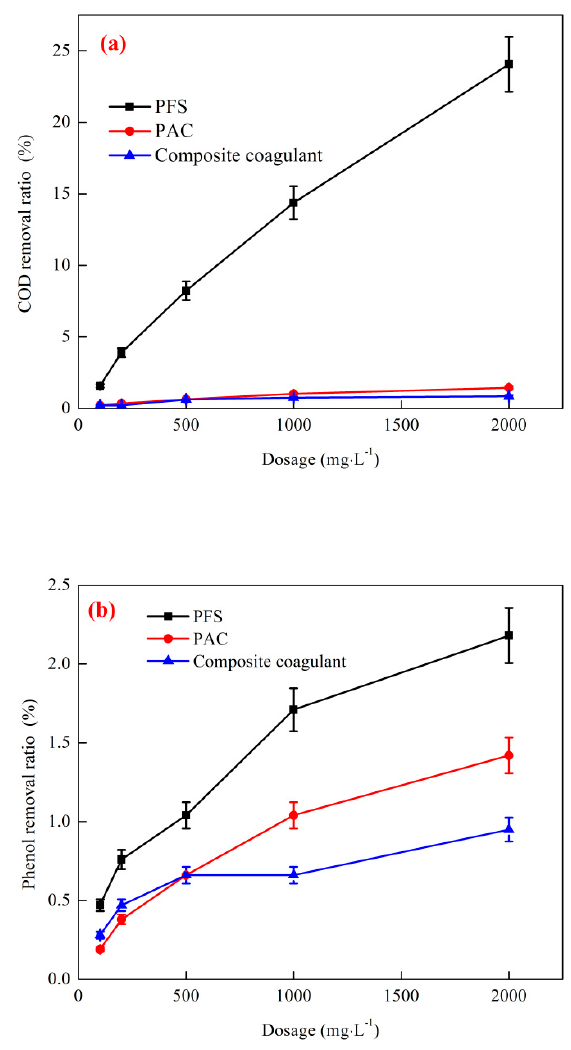
Figure 7. E ff ect of di ff erent coagulants on the coagulation of coking wastewater. ( a ) COD removal; ( b ) Phenol Figure 7. Effect of different coagulants on the coagulation of coking wastewater. (a) COD removal; (b) Phenol removal.